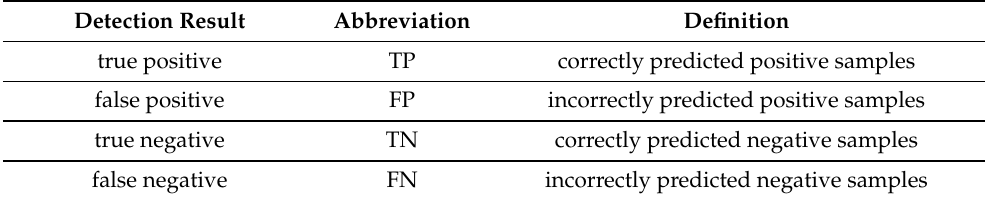
Table 1. A brief introduction to TP, FP, TN, and